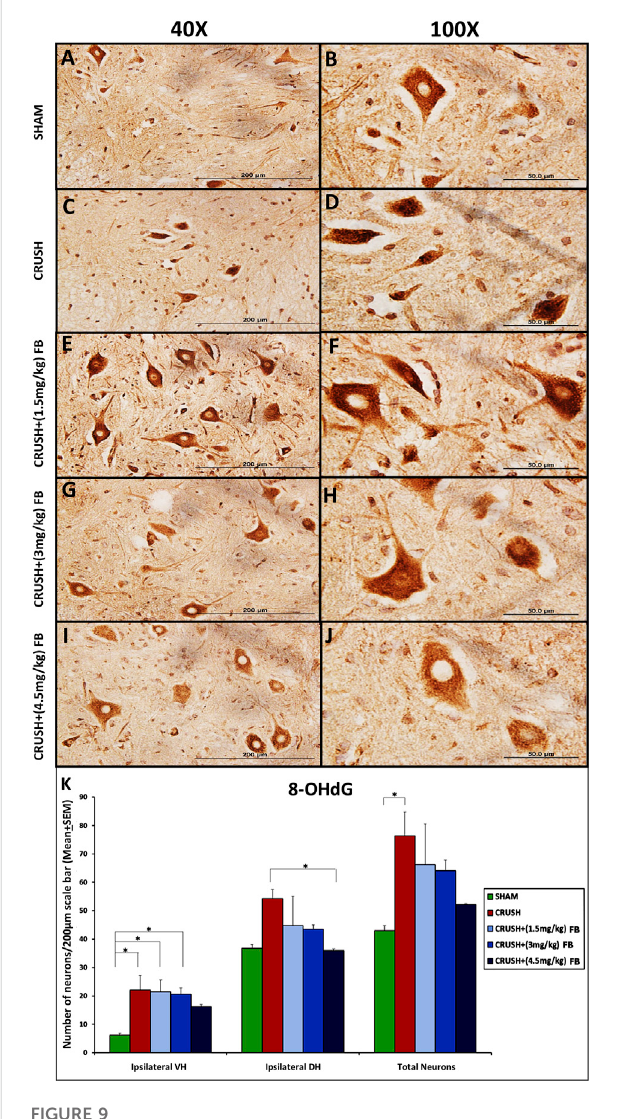
FIGURE 9 (A – J) : Representative immunohistochemical staining of 8-OHdG in the ventral horn segment of the spinal cord after sciatic nerve crush injury. 8-OHdG positive neurons were identi fi ed with brown nuclei among all experimental groups (Magni fi cation ×40 and 100x). (K) After sciatic nerve crush injury, the number of positive neurons for 8- OHdG in the spinal cord ’ s ipsilateral ventral and dorsal horns. 8-OHdG positive neurons were highly identi fi ed in the ventral horn of the spinal cord in the CRUSH group after injury. FB-treated groups showed lower 8-OHdG expression in the spinal cord when compared to the CRUSH group. Data are expressed as mean ± SEM. * p < 0.05, ** p < 0.01, and *** p <